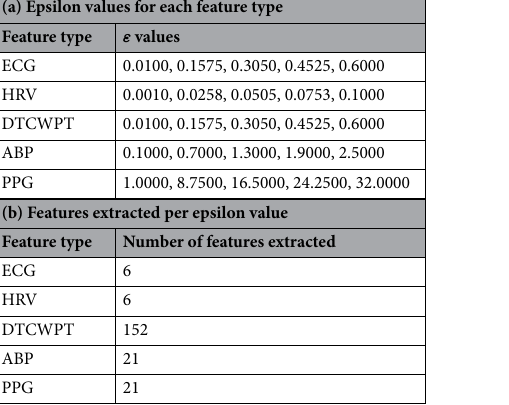
Table 1. Taut string estimation